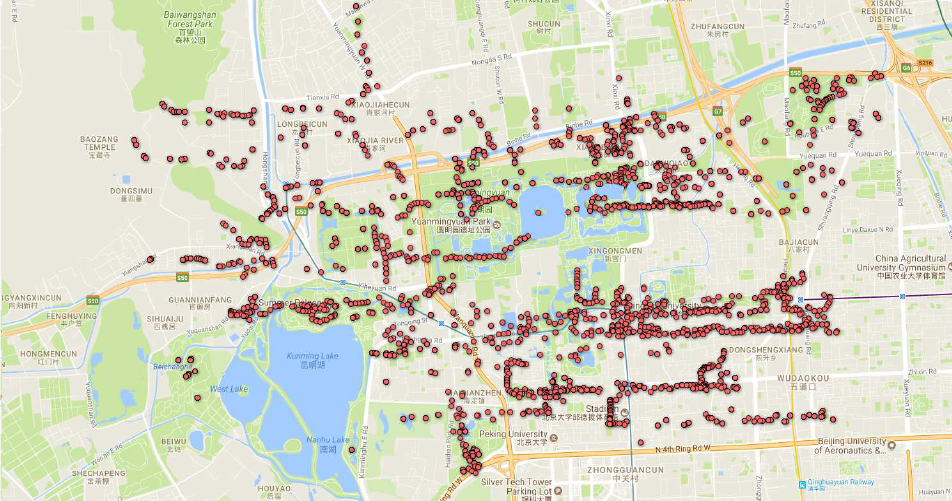
Figure 4. Anonymized locations of a